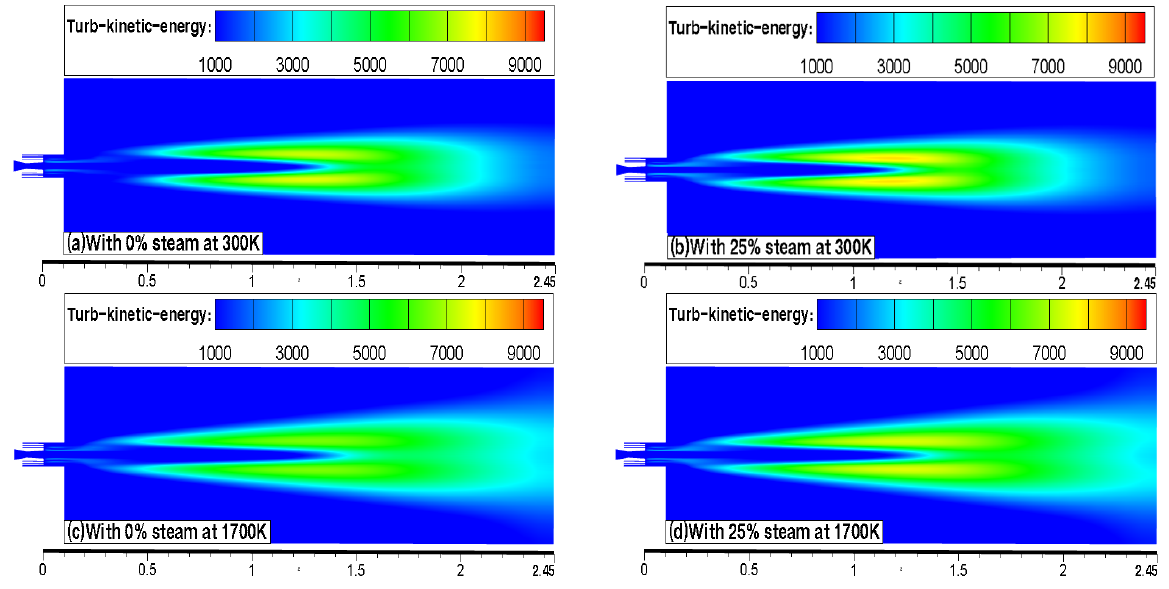
Figure 13. Axial cross-sectional distributions of the turbulent flow energy of the coherent supersonic jet at different temperatures and different water contents: ( a ) 0% steam and 100% oxygen at 300 K; ( b ) 25% steam and 75% oxygen at 300 K; ( c ) 0% steam and 100% oxygen at 1700 K; and ( d ) 25% steam and 75% oxygen at 1700 K.